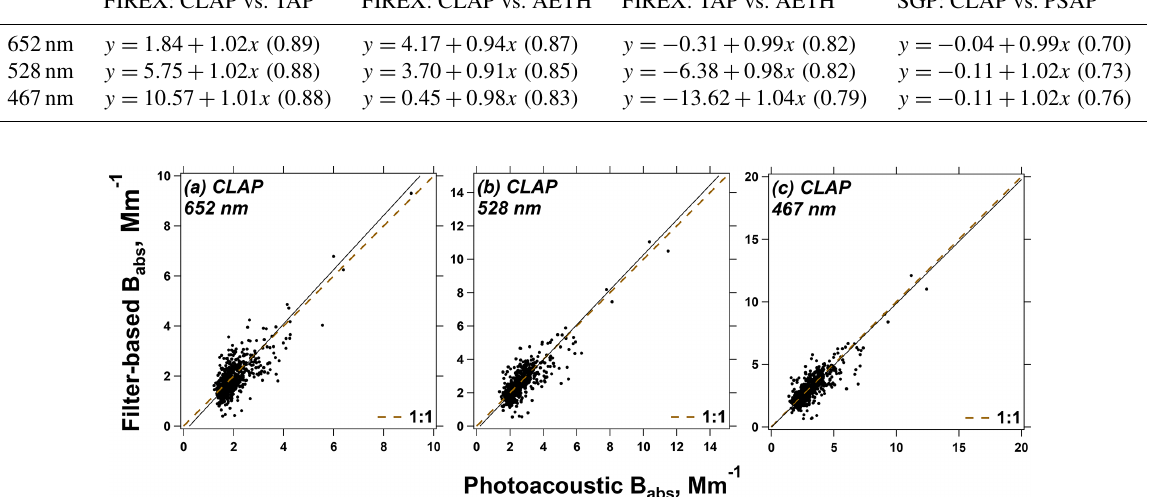
Figure 8. Intercomparison between the CLAP-derived B abs corrected by Algorithm A in the present work and reference B abs at 652, 528, and 467nm for the ambient data at the SGP study area. The solid line represents the linear regression, while the dashed line is a 1 : 1